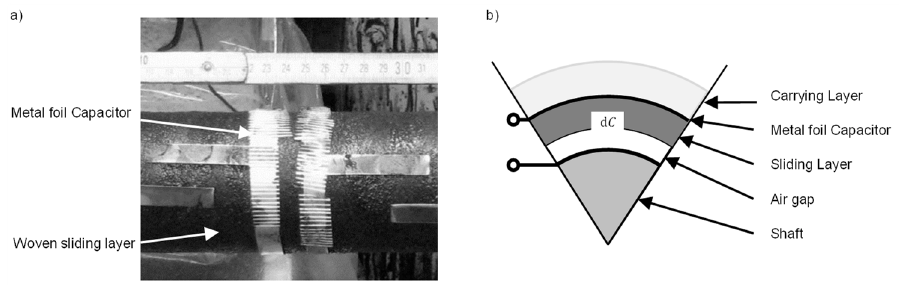
Figure 6. ( a ) Added metal foils as cylindrical capacitors during the manufacturing process of the sensorial sliding bearing prototypes; ( b ) infinitesimal element of the capacitor C ; both by [53].